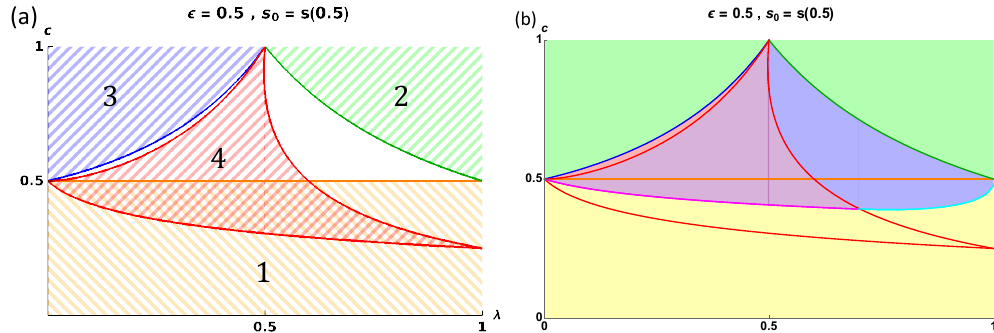
Figure 31 . Regions 1-4 in (a) show the parameter ranges for which f 1 through f 4 are given by the saddle-point values in the first lines of (C.88)–(C.91). The resulting phase diagram for the logarithmic negativity is shown in (b). Different shaded regions correspond to distinct phases. All lines from (a), including those that do not correspond to phase transition lines of the logarithmic negativity, are also shown in (b) to make it easier to compare regions in the two